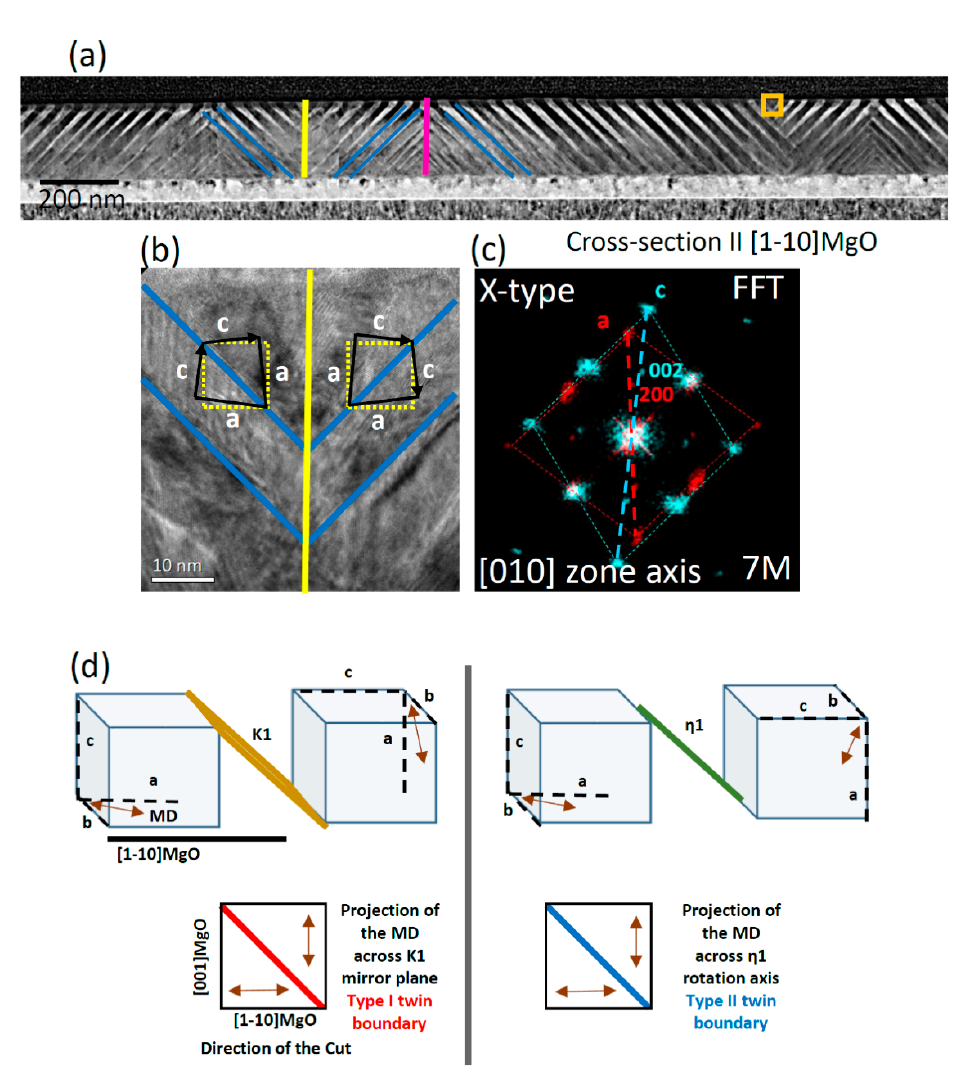
Figure 3. ( a ) Large-scale HAADF image of sample #2, the twin boundaries and the conjugation interfaces are marked by blue, pink, and yellow lines; ( b ) HR-TEM of the marked area in panel ( a ) showing the symmetry of the martensitic cells across the twin boundary and the conjugation interface; ( c ) FFT pattern taken at the twin boundary (shown in panel ( b ), left) showing the a and the c axes (black lines) alternating across the twin boundary, the yellow dashed lines aligned along the [001] and [1 − 10] directions of MgO are guides for the eyes to evidence the observed cell misorientation; cell parameters are fitted to the 7M monoclinic cell; ( d ) top: schematic representation of the martensitic cell axes and the modulation direction in X-type across type I, type II boundaries (austenitic setting), bottom: the corresponding projection of the modulation direction in the plane of the lamella (FIB-cut along [1 −